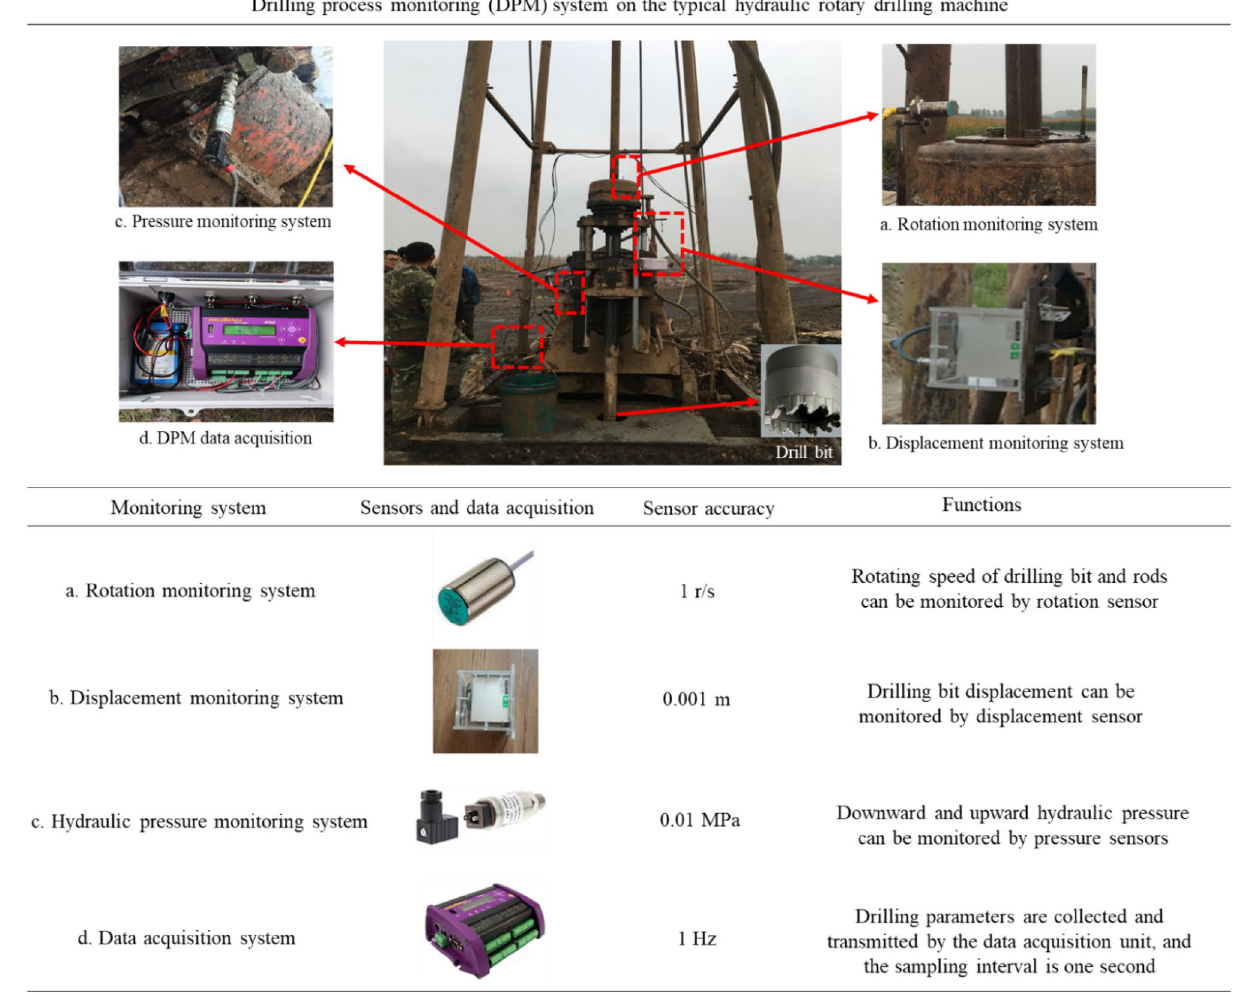
Figure 2. Schematic diagram of digitalization